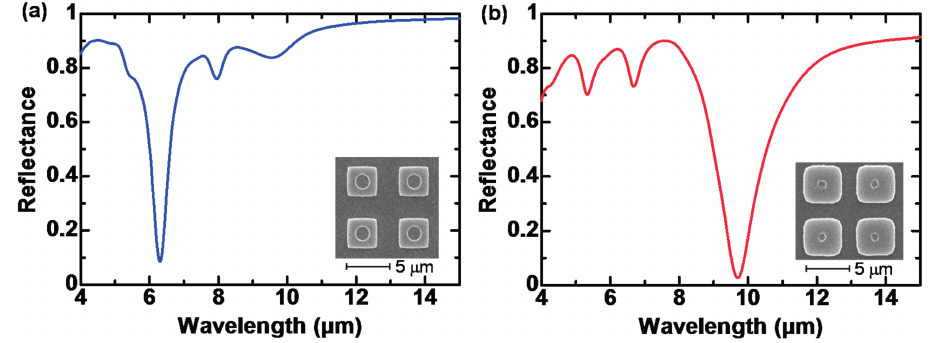
Figure 13. Experimental reflectance spectra for devices with w m and w h of ( a ) 3.5 and 1.5 µ m; and ( b ) 4.3 and 0.7 µ